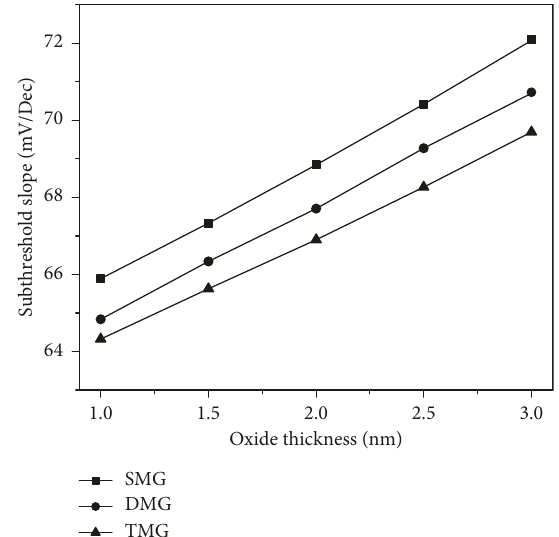
Figure 13: Subthreshold slope for SMG, DMG, and TMG Re-S/D SOI MOSFET versus oxide thickness at 90nm channel length.